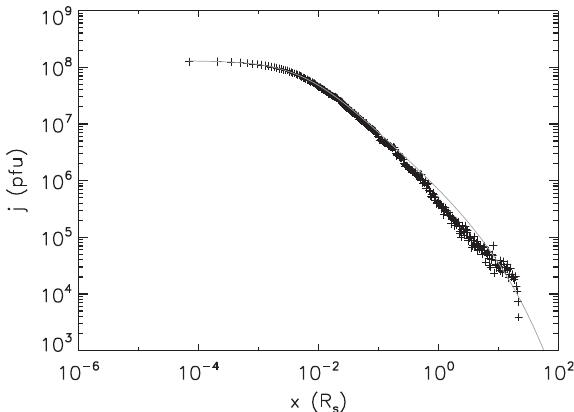
Fig. 2. An example of the fit to the spatial distribution ahead of the shock at E ¼ E 0 . The case considered is Run 2c.